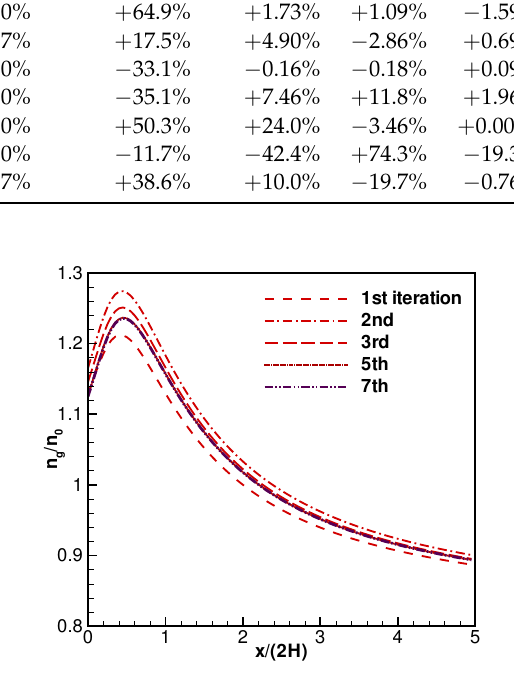
Figure 15. Test case: mixture centerline density profile development history.